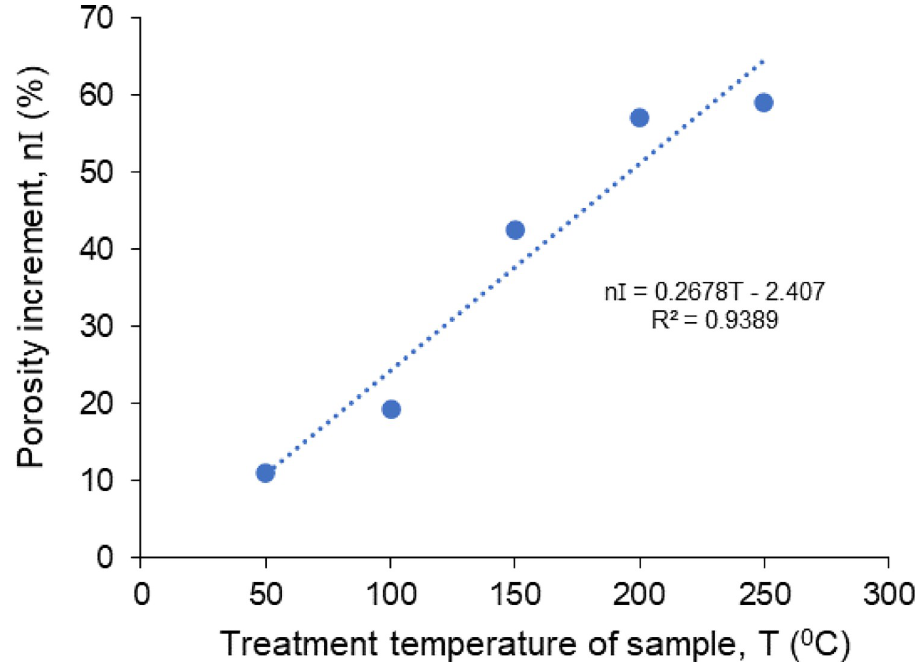
Fig 12. The porosity increments with increasing treatment temperatures of rock salt